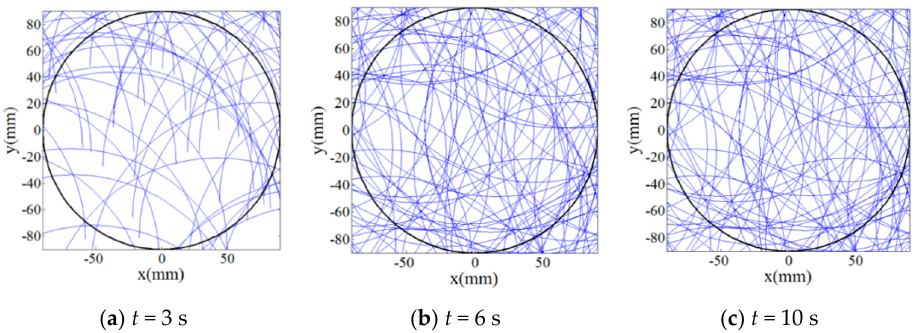
Figure 7. Relation between trajectories of multiple abrasive particles on target surface at i pw = 1 and lapping time ( a ) t = 3 s; ( b ) t = 6 s; ( c ) t = 10 s (black lines represent the profile of the workpiece and blue lines represent trajectories of multiple abrasive particles on the target surface).